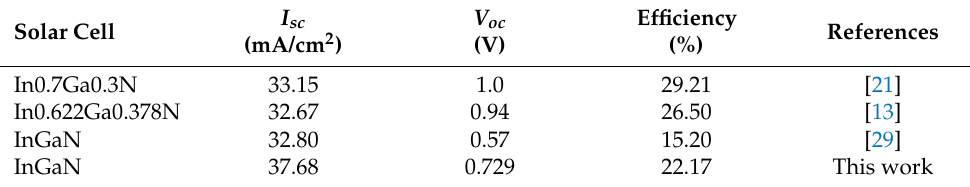
Table 2. Summary of optimized parameters of the InGaN solar cell.